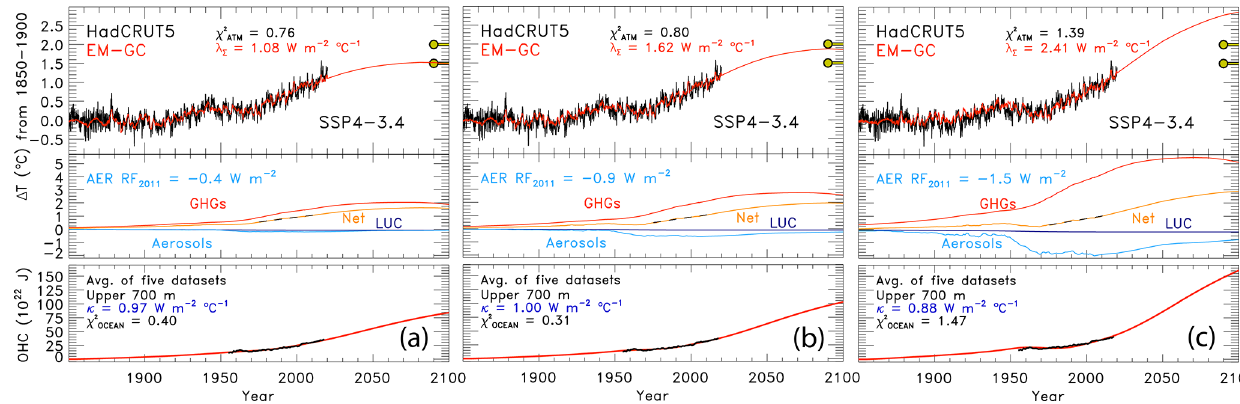
Figure 3. Measured (HadCRUT5) and EM-GC simulated GMST anomaly ( (cid:49)T ) relative to a pre-industrial (1850–1900) baseline, as well as projected (cid:49)T to the end of the century for SSP4-3.4. The top box in each panel displays observed (black) and simulated (red) (cid:49)T , as well as the values of λ (cid:54) and χ 2 for each model run. The Paris Agreement target (1.5 ◦ C) and upper limit (2.0 ◦ C) are shown (gold circles). The ATM middle boxes show the contribution of GHGs, aerosols, and land-use change to (cid:49)T , as well as the net human component. The bottom boxes compare observed (black) and modeled (red) values of OHC for simulations constrained by the average of five data sets (see text) and also provides the numerical values of κ needed to obtain best fits to the OHC record as well as best-fit values of χ 2 . The only difference OCEAN between (a) , (b) , and (c) is the time series for RF due to tropospheric aerosols used to constrain the EM-GC; values of AER RF 2011 for each time series are (a) − 0 . 4Wm − 2 , (b) − 0 . 9Wm − 2 , and (c) − 1 . 5Wm − 2